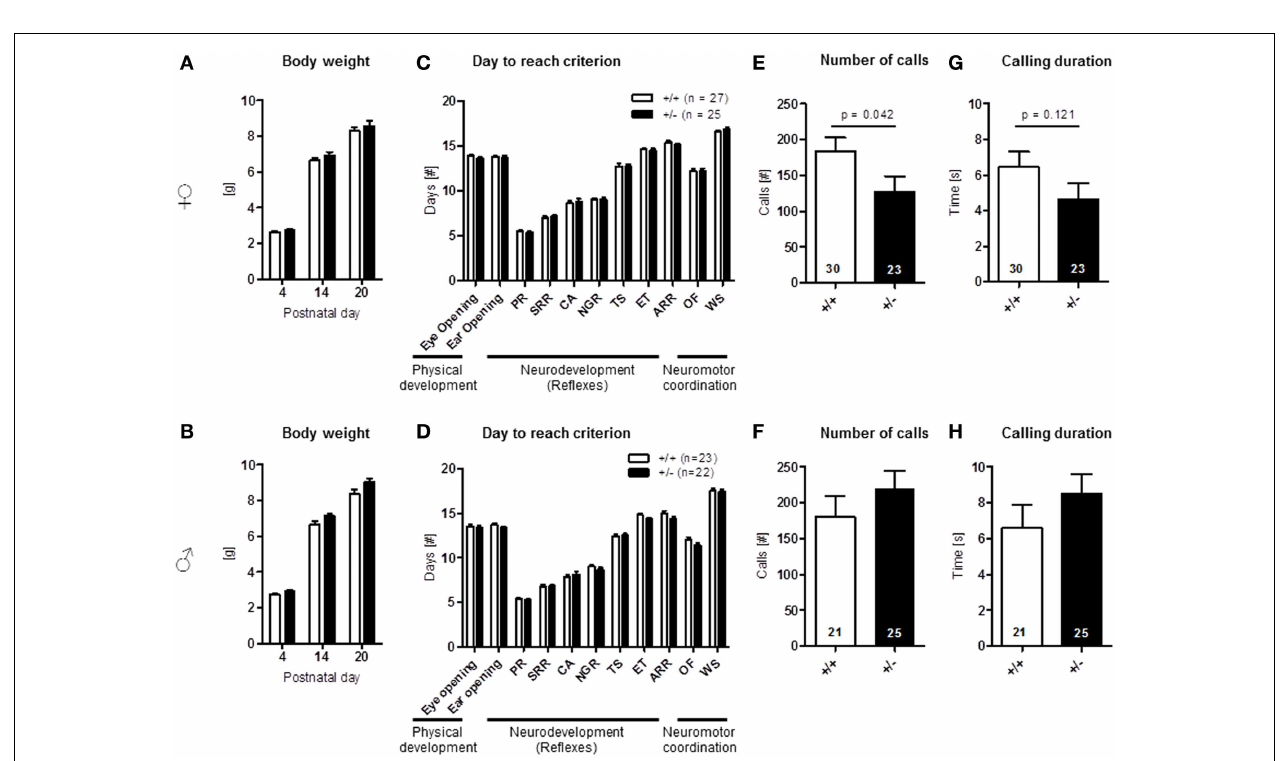
FIGURE 8 |Autism composite score results for Ambra1 + / − versus Ambra1 + / + mice of both genders underline the female autism-like phenotype in Ambra1 + / − .The upper row presents results for female, the lower row for male mice. (A,B) Highly significant genotype-dependent score